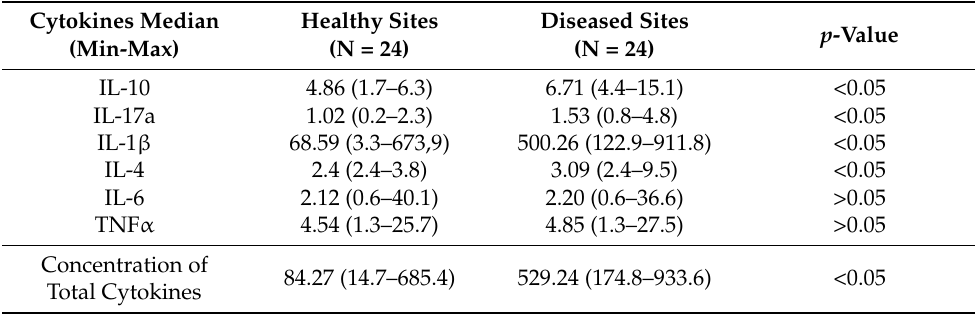
Table 3. Cytokines concentration comparison between healthy and diseased